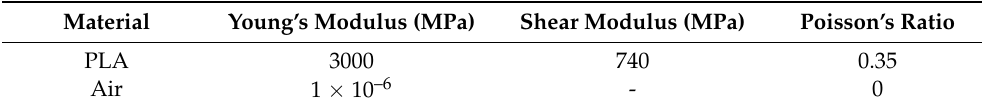
Table 2. Material